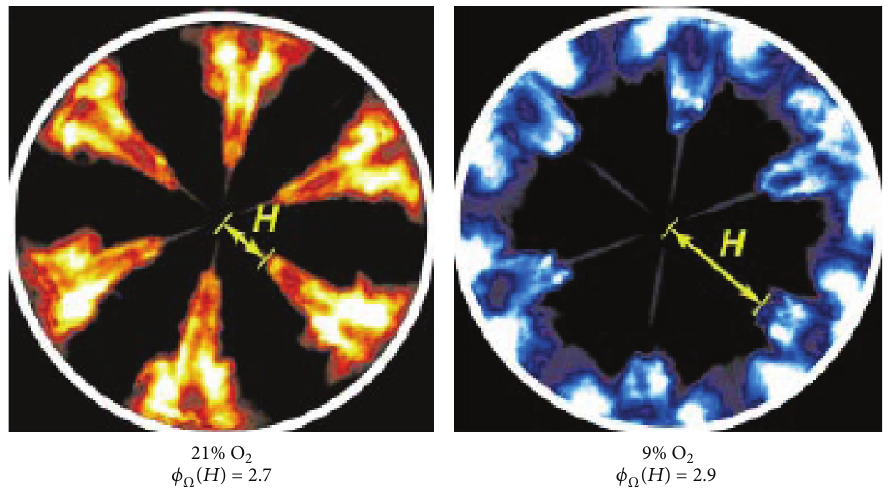
Figure 12: The imaging of conventional diesel and LTC